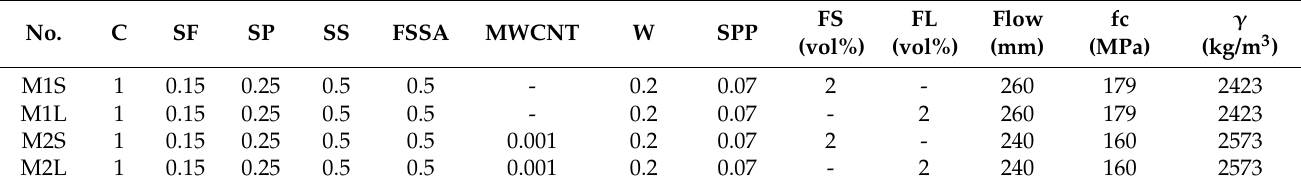
Table 2. Composition by weight ratio, flow, compressive strength, and density of S-UHPCs.